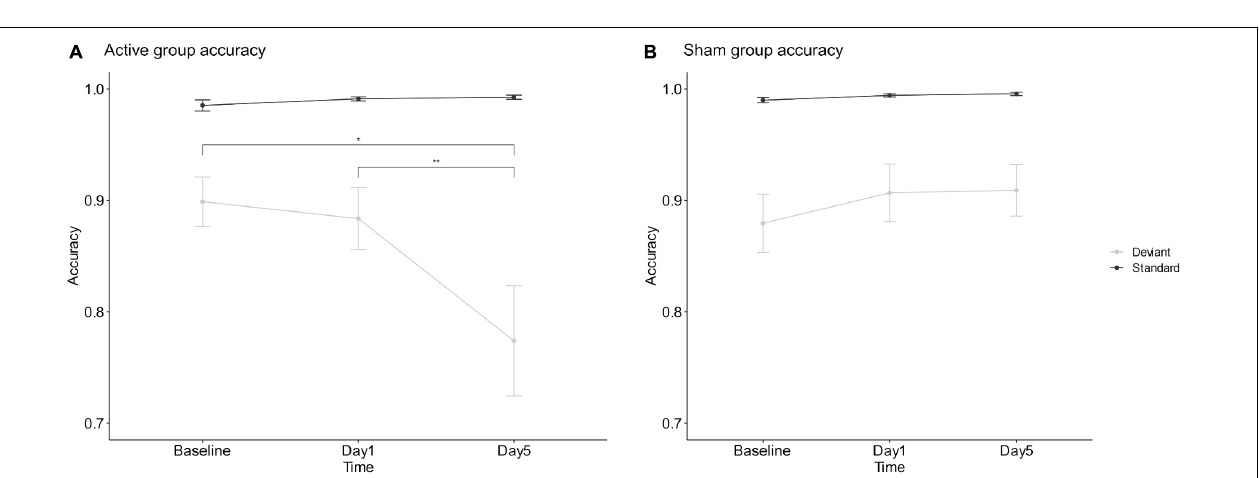
FIGURE 3 | Mean accuracy of active tDCS group (A) and sham group (B) . *Refers to 2-sided p < 0.05. **Refers to 2-sided p < 0.01. Error bars show the standard error of the mean.